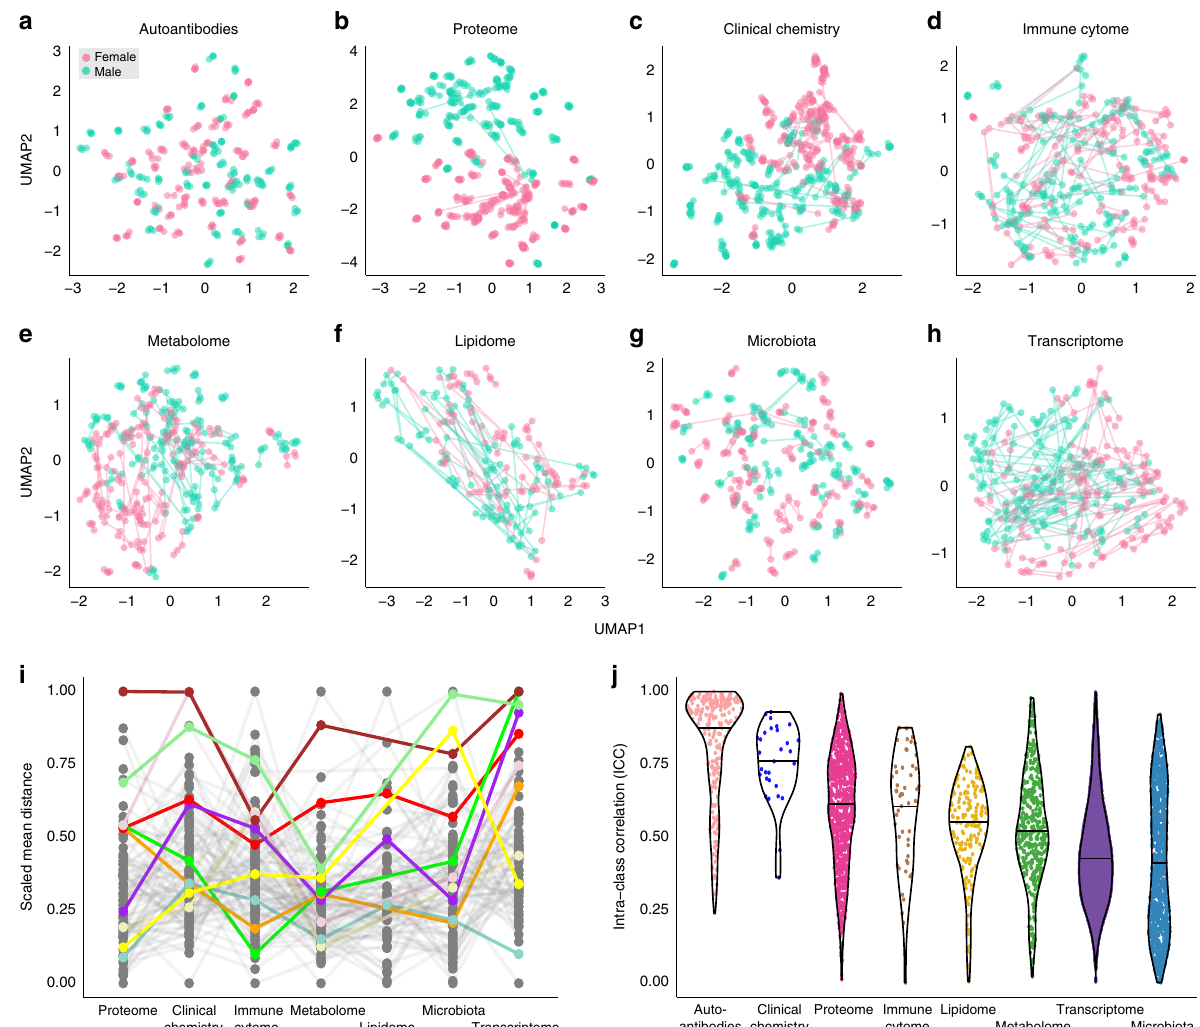
Fig. 3 Global molecular pro fi les and the individual variation. The global pro fi les across visits were analyzed using UMAP for eight different datasets used in the study: a autoantibodies ( n = 318) analyzed in plasma and based on 91 subjects; b plasma protein expression data for 794 proteins in 90 subjects; c clinical chemistry and hematology variables ( n = 30) based on 94 subjects; d immune cell pro fi les from PBMC ( n = 53) based on 93 subjects; e metabolites in plasma ( n = 413) based on 94 subjects; f lipids in plasma ( n = 169) based on 48 subjects; g fecal microbiota based on 16S sequencing and using 1465 operational taxonomic units (OTUs) for 89 subjects; and h PBMC transcriptome expression values from 11,976 genes based on 77 subjects. Each plot shows all individuals with complete data from all four visits for the respective datasets, except for the proteome and clinical chemistry data where six visits were analyzed, colored by sex and with lines connecting the visits for each individual. i The average distance between visits for each individual calculated per data type. The autoantibody pro fi ling was excluded from this analysis due to the high stability over time. Euclidean distance was used for all methods except microbiota, which used Bray – Curtis distance, and immune cytome, which used Aitchisons distance. The individuals with the top ten largest average distances are highlighted in different colors and all others are shown in gray. j Intra-class correlation (ICC) levels in each variable from each dataset. In j data are represented as violin plots where the middle line is the